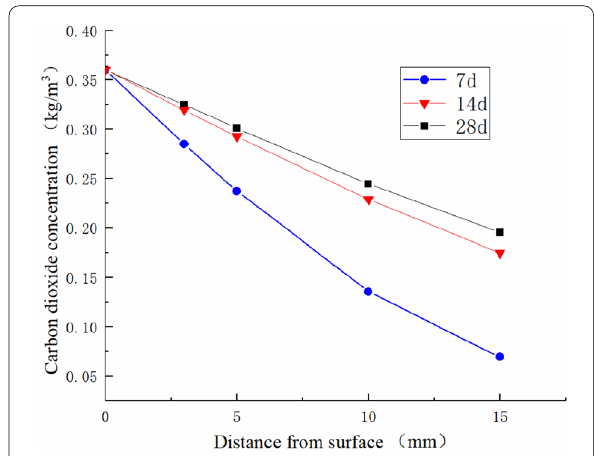
Fig. 9 Variations of carbon dioxide concentration with the depth for different carbonation ages.